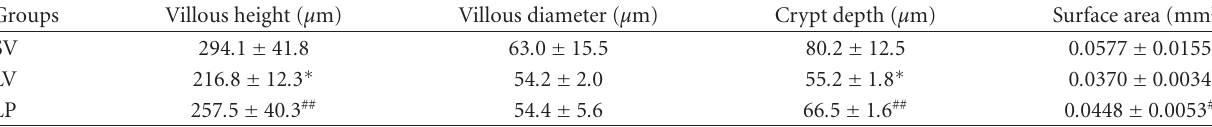
Table 1: Changes in villous height, diameter, crypt depth, and surface area of mucosa (Values were expressed as mean ± SD.)